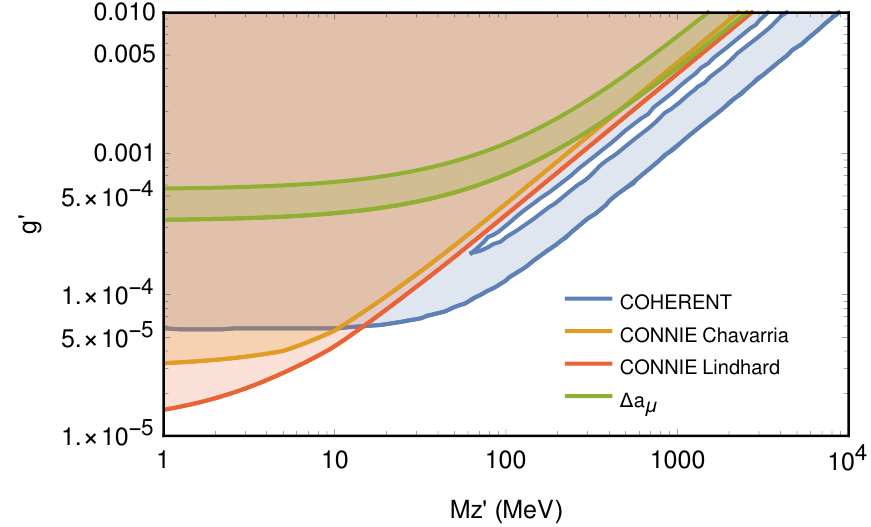
Figure 2 . Exclusion region in the ( M Z 0 ; g 0 ) plane from the CONNIE results assuming quenching given by the (cid:12)t to the measurements in ref. [33] (orange) and the expressions in ref. [34] (red). The COHERENT limit curve [5] (blue) and the 2 (cid:27) allowed region to explain the anomalous magnetic moment of the muon ((cid:1) a (cid:22) = 268 (cid:6) 63 (cid:2) 10 (cid:0) 11 ) [35, 36] (green) are shown for reference.